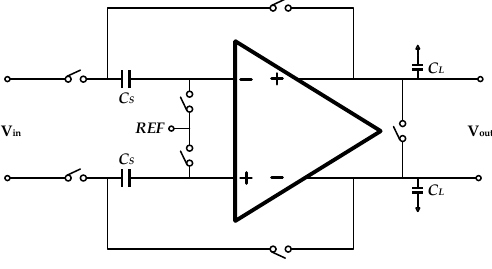
Figure 8. Overall design of the employed differential S/H.